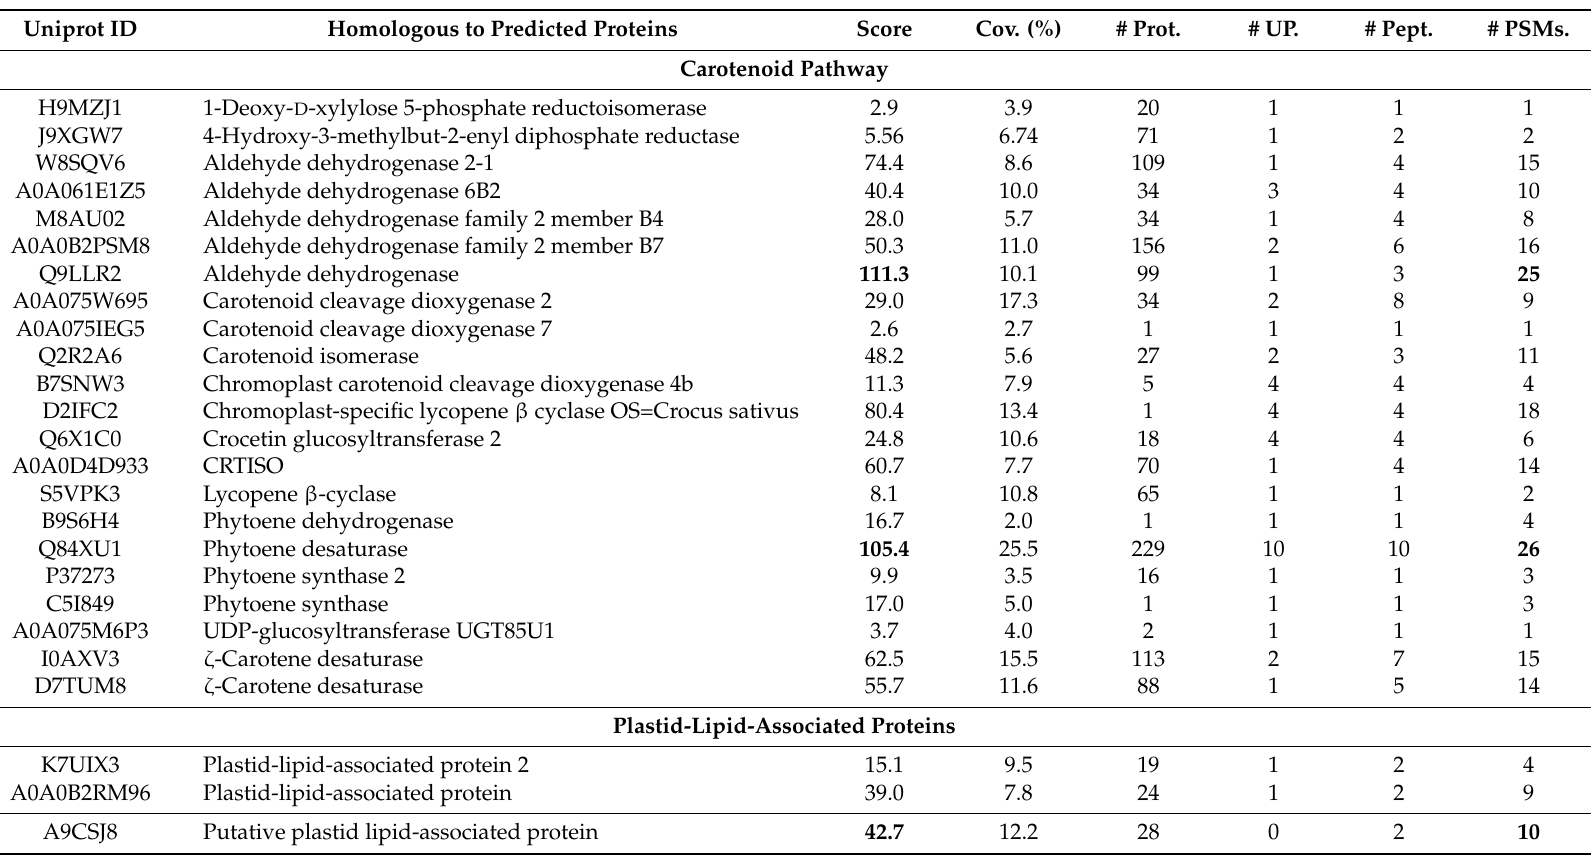
Table 1. Identification of proteins involved in carotenoid pathway and plastid-lipid-associated proteins, deduced from LC-MS/MS data of fraction F1 from saffron